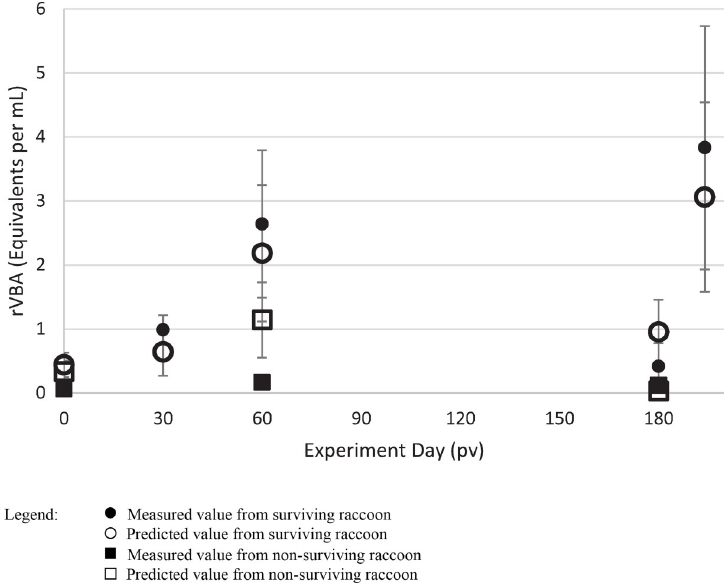
Fig 2. Measured and predicted rabies binding antibody values (rVBA) in raccoons at post-vaccination (pv). Infection occurred on day 180 pv. Error bars represent standard